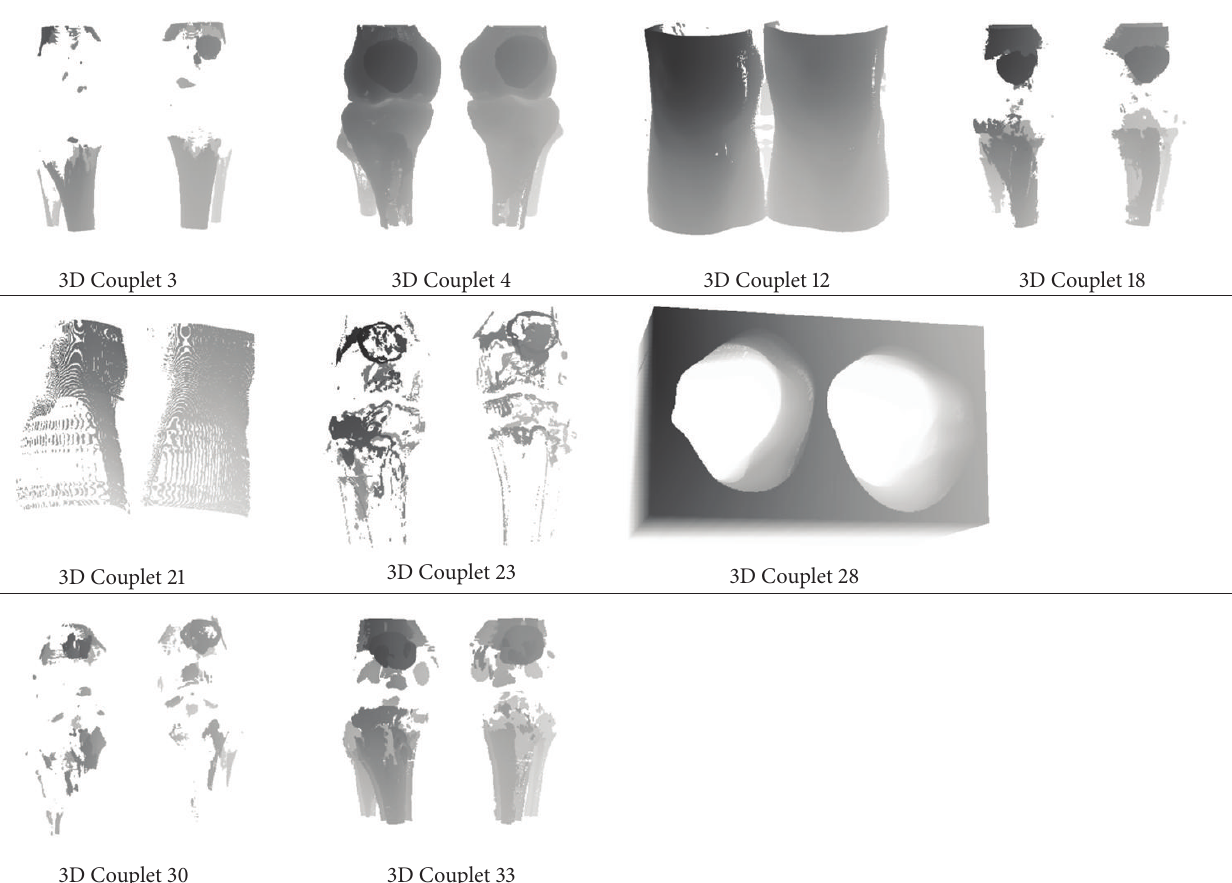
Table 14: Some 3D couplets, perpendicular to color axis, extracted from the 4D-EVM produced by means of Framework 𝑛 D-EVM/Kohonen and associated to dataset VL-CT-Knee .